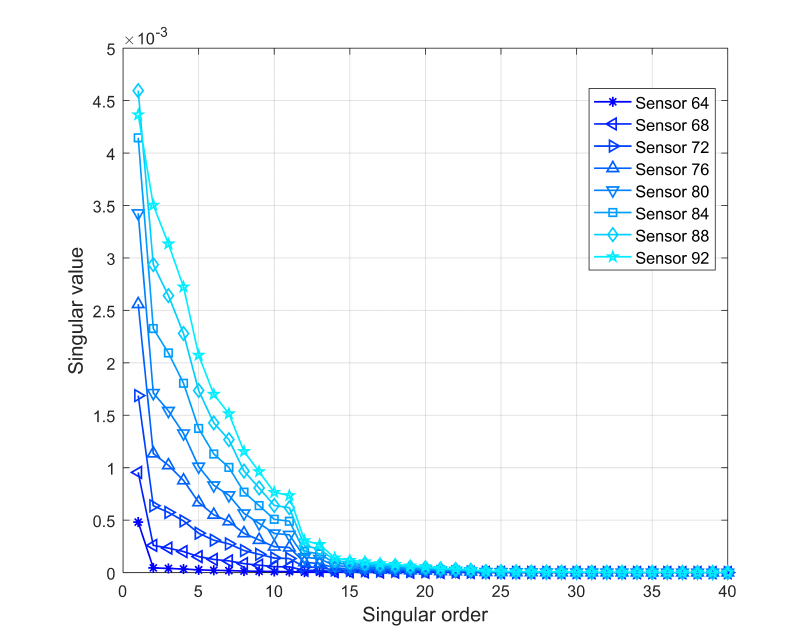
Figure 21. Wavelet packet singular values of noisy U x with SNR=60 dB.